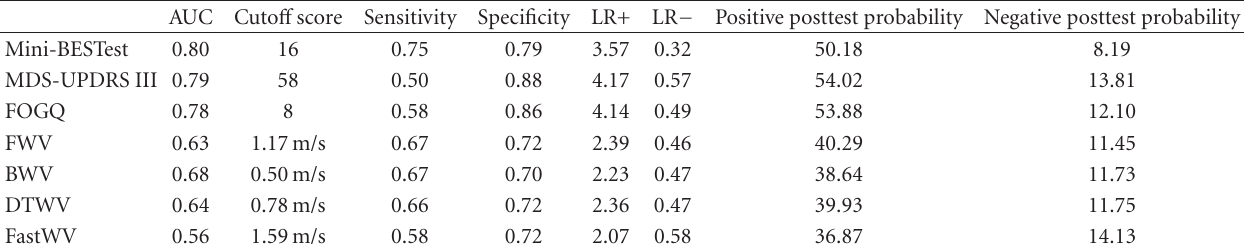
Table 2: Predictive values and noninferiority comparisons for all outcome